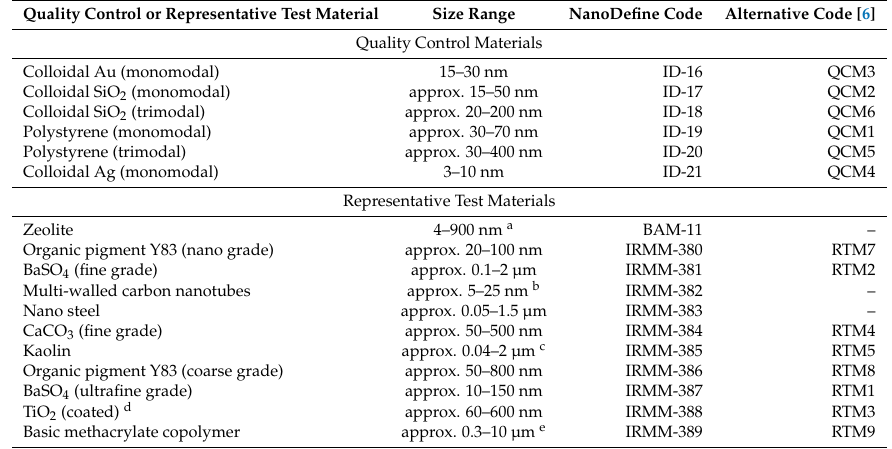
Table 1. Quality control and representative test materials considered in the NanoDefine